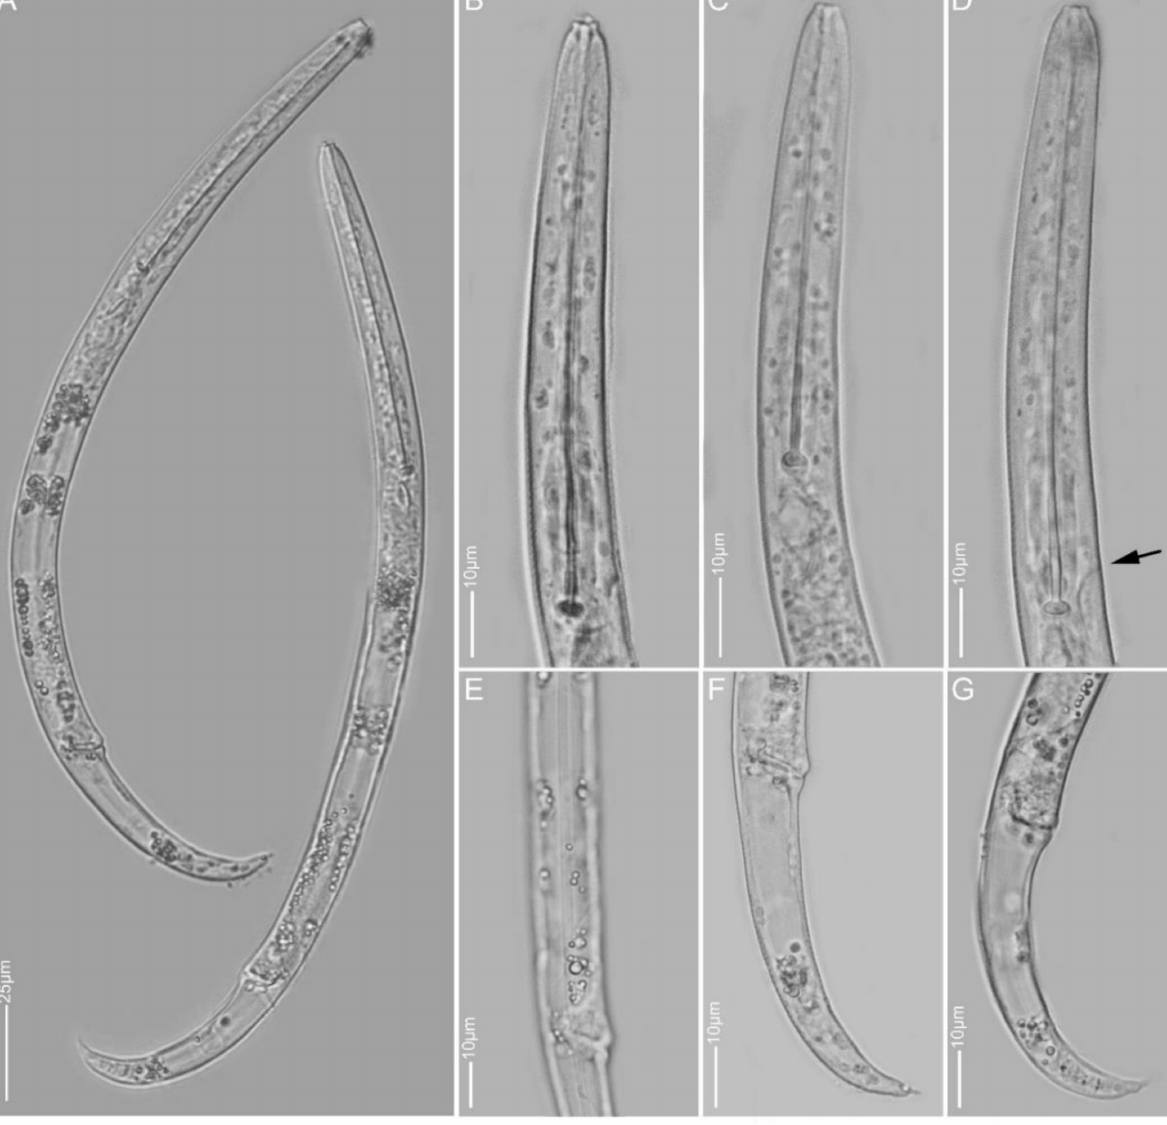
Figure 5. Light microscopy images of Paratylenchus idalimus females from sample BE19: ( A ) total body; ( B – D ) anterior region; ( E – G ) lateral field and tail region; arrow pointed to secretory–excretory pore in